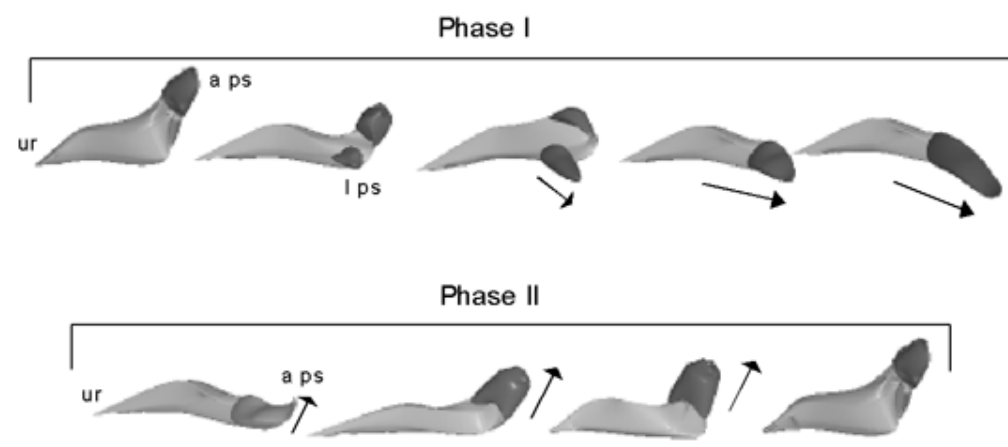
FIGURE 5 . Dictyostelium amoebae crawl in buffer in a cyclic manner with a 1-min period (“behavior cycle”). This behavior cycle has two phases (I, II) depicted in 3D reconstructions. Pseudopods dark gray, cell body light gray. Arrow denotes direction of pseudopod extension (see [38] for